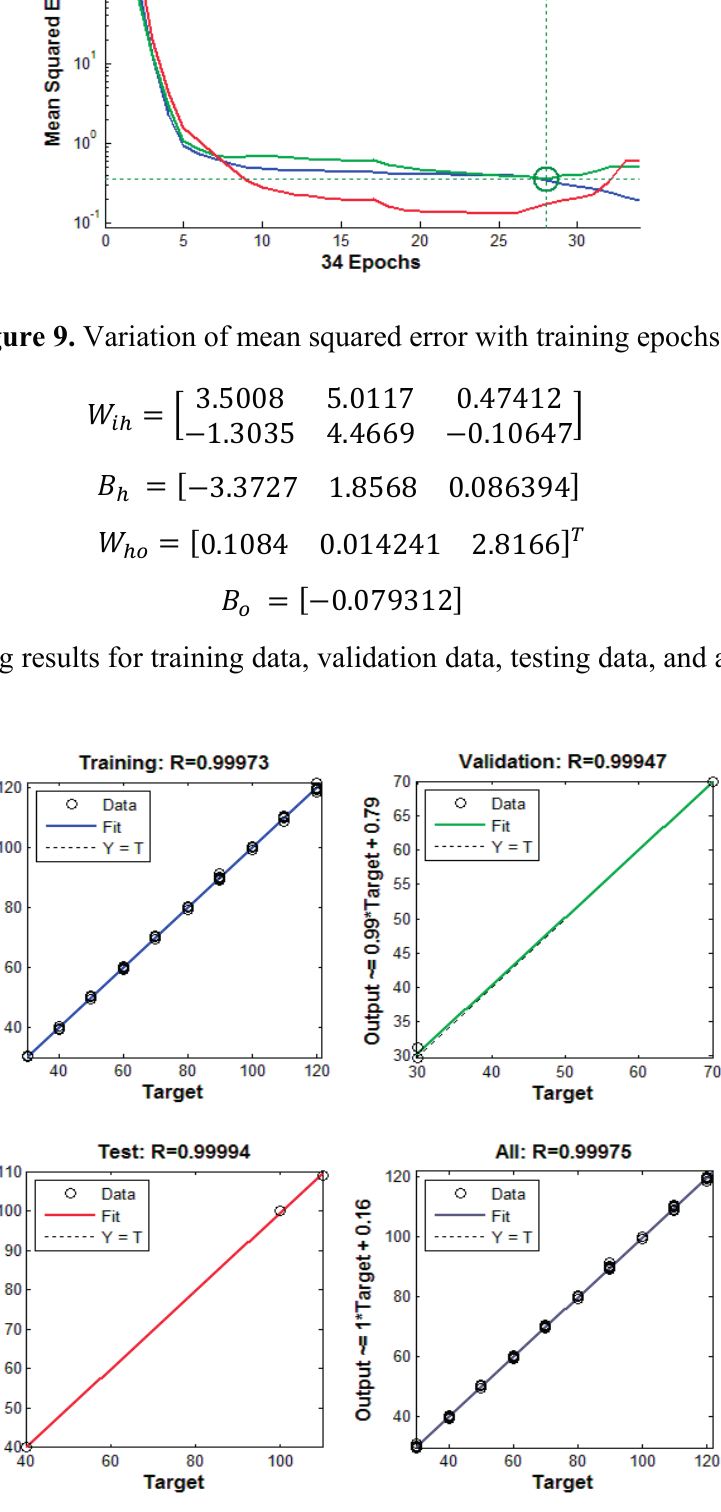
Figure 10. The agreement between the network’s output intensity and target